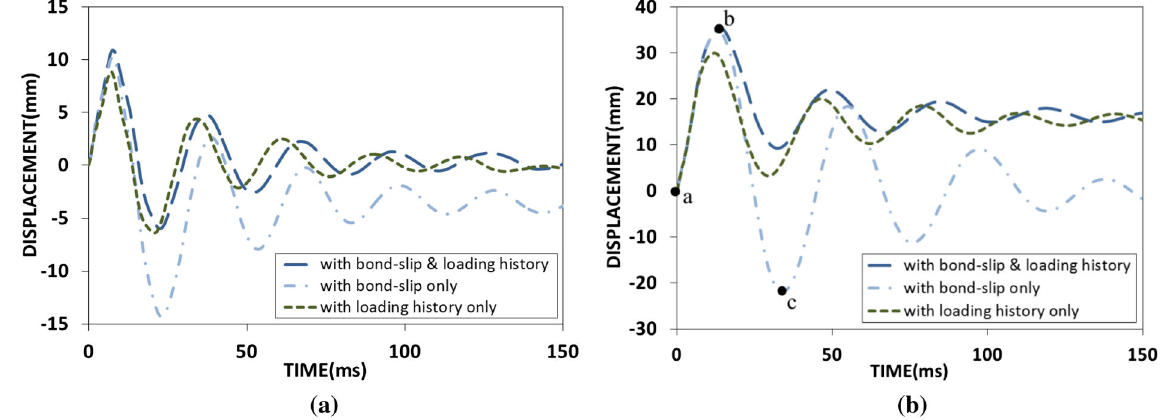
Fig. 14 Mid-span deflection with time for beams a SS3a and b SS3b, considering bond-slip and loading